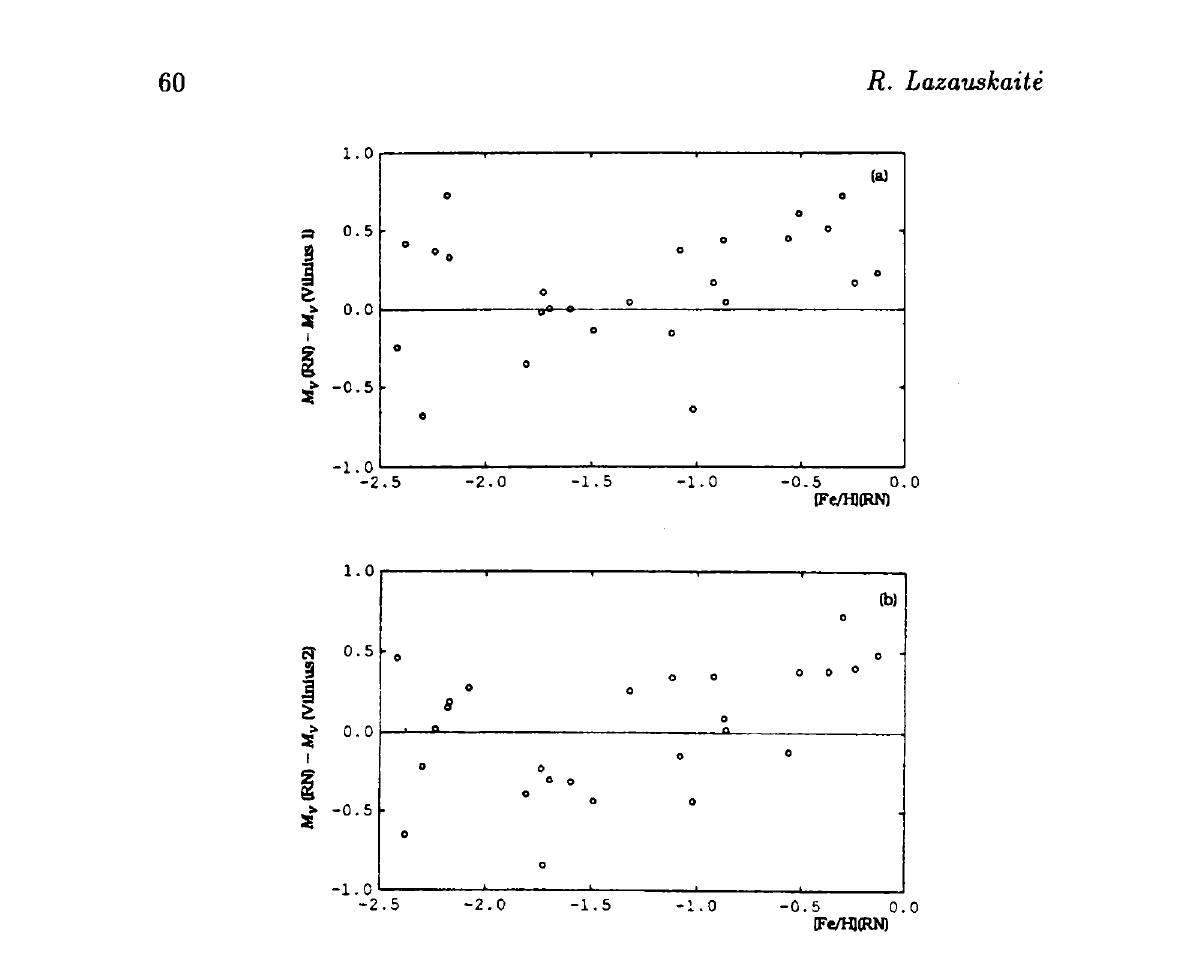
Fig. 4. Comparison of the absolute magnitudes derived by RN and those estimated from Equations (1) (a) and (2)